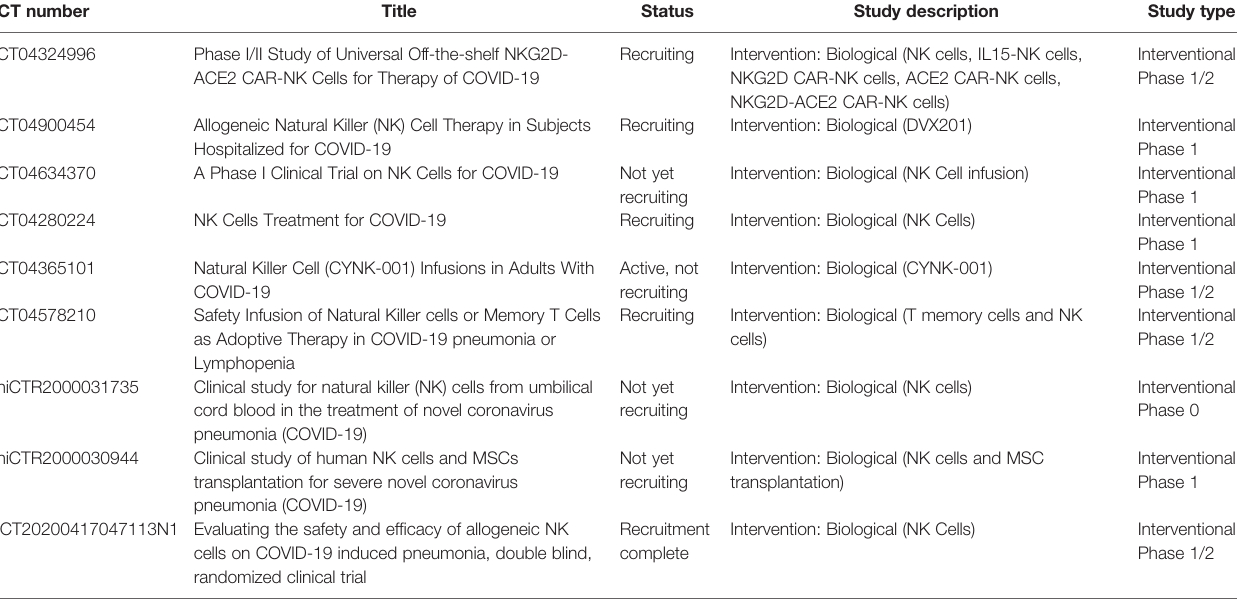
TABLE 1 | List of clinical trials proposed for COVID-19 treatment and based on primary and “ off-the-shelf ” NK